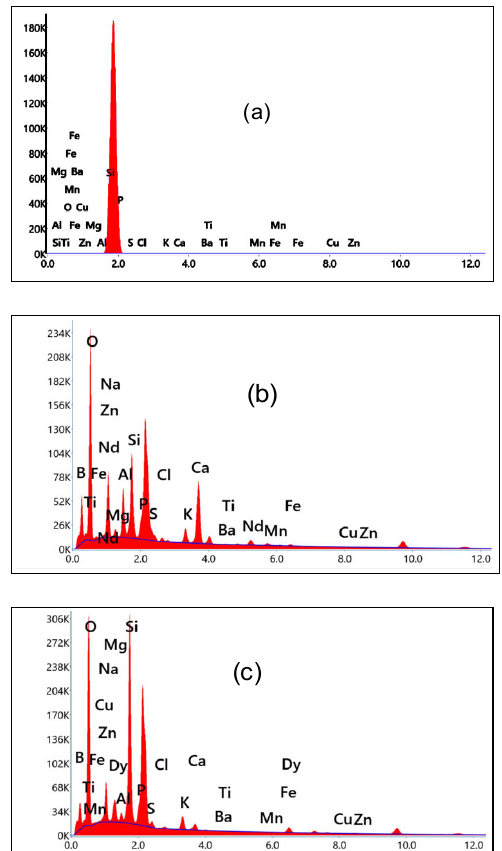
Figure 2. EDX spectra for ( a ) RA, ( b ) GRN, and ( c ) GRD samples.